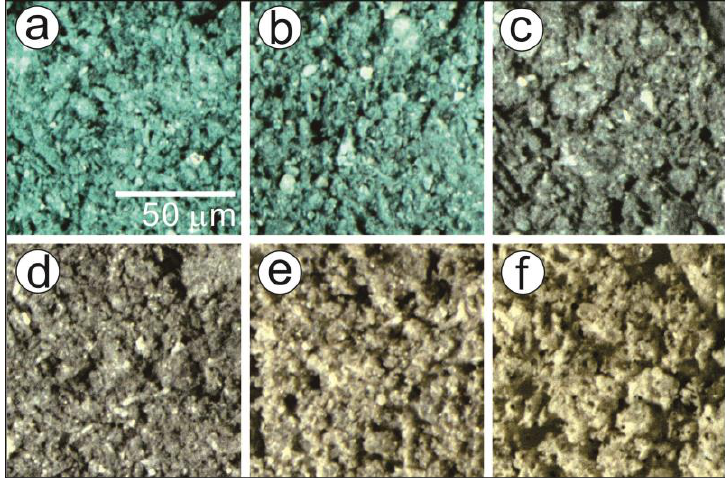
Figure 12. Typical optical microscopic views of the P-MB heated to different temperatures: ( a ) original sample, ( b ) 573 K, ( c ) 713 K, ( d ) 793 K, ( e ) 1003 K, and ( f ) 1223 K.